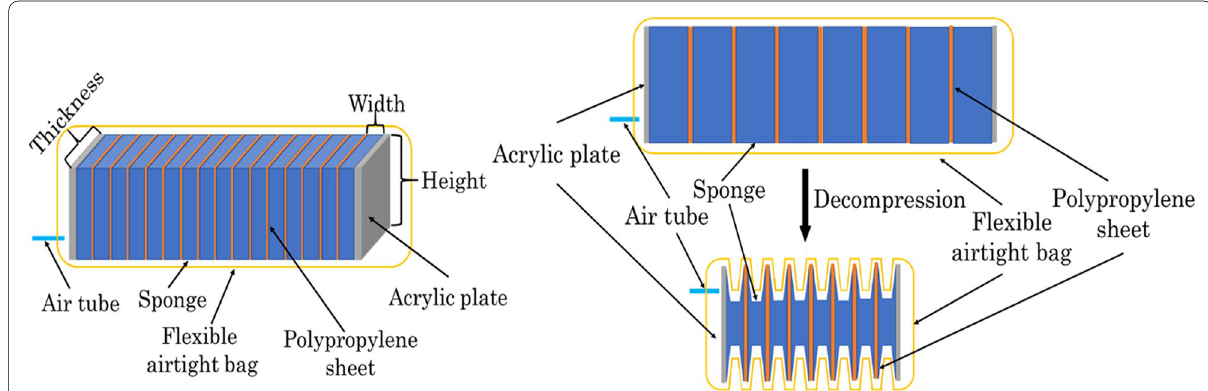
Fig. 1 Schematic illustration of a developed telescopic actuator. The telescopic actuator is composed of rectangular sponges that are interleaved with polypropylene sheets sealed in a flexible airtight bag. When the inside air of the bag is evacuated, the sponges are contracted, which shortens the actuator